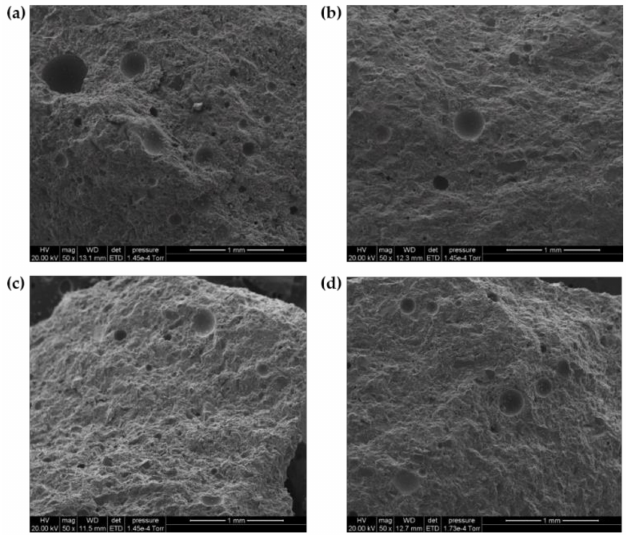
Figure 12. Selected ESEM images of G2anis_6 ( a ), G2anisM_6 ( b ), G2is_6 ( c ) and G2isM_6 ( d ).